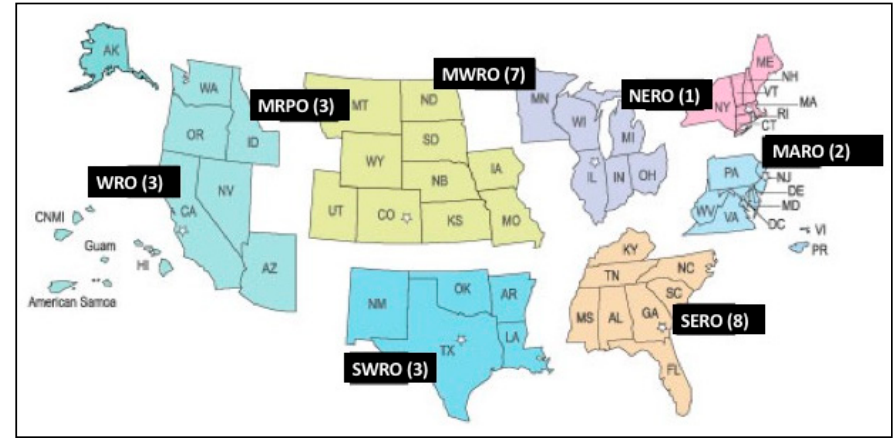
Figure 1 . Interview Respondent Locations. Note: SERO (Southeast Regional Office); SWRO (Southwest Regional Office); MARO (Mid-Atlantic Regional Office); NERO (Northeast Regional Office); MWRO (Midwest Regional Office); MRPO (Mountain Regional Plains Office); WRO (West Regional Office) Table 2. Interview Participant Demographics ( n =